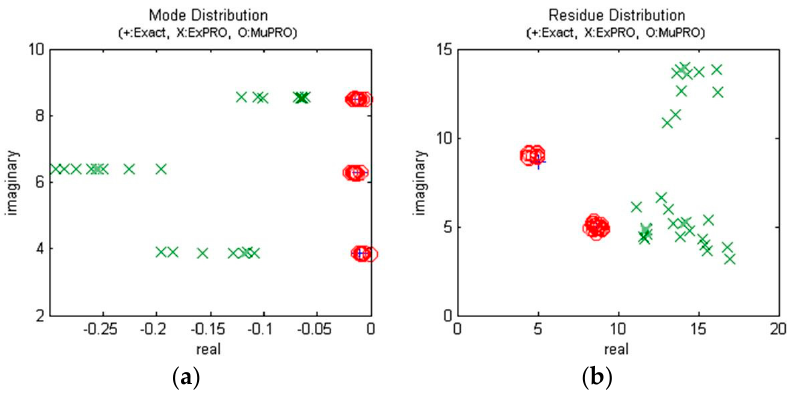
Figure 6. Distribution of mode and residue (sampling 1/60 s, α = − 0.01). ( a ) Mode; and ( b ) residue.